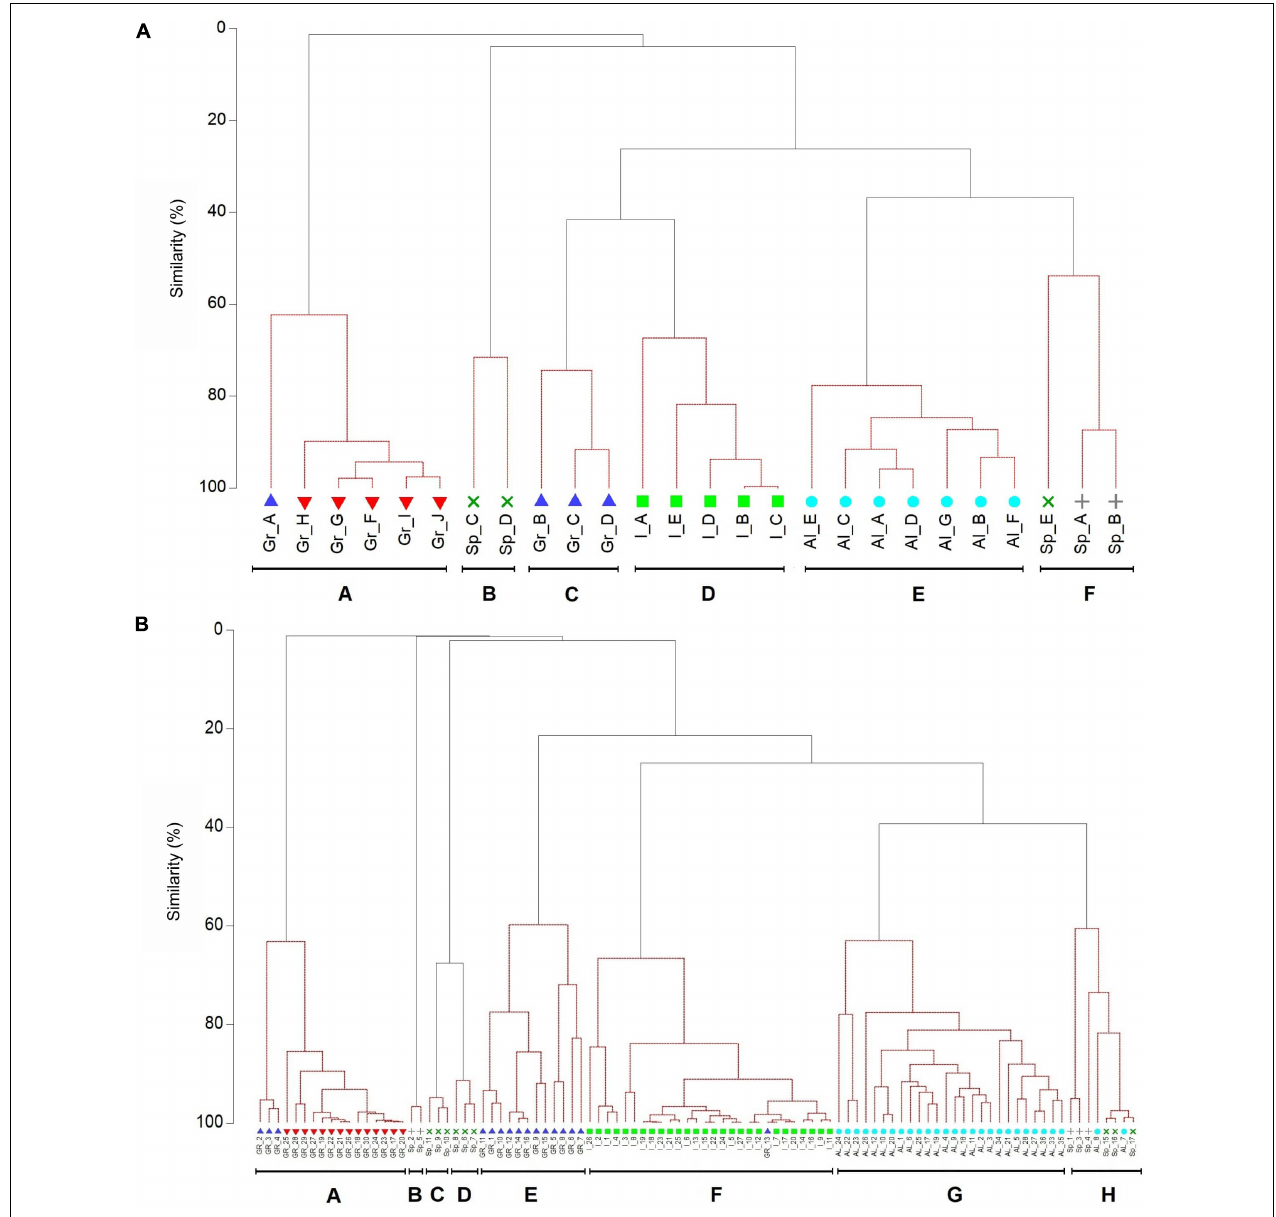
FIGURE 5 | Dendrogram from group-average clustering of the fucalean species percentage cover at forest (A) , transect (B) spatial scales. Continuous lines indicate the groups which were significantly differentiated by SIMPROF tests (at the 5% level). Within each of these groups, the null hypothesis that all pairs of species have the same association to each other cannot be rejected, the subgroup structure identified by cluster analysis thus having no statistical support (dashed